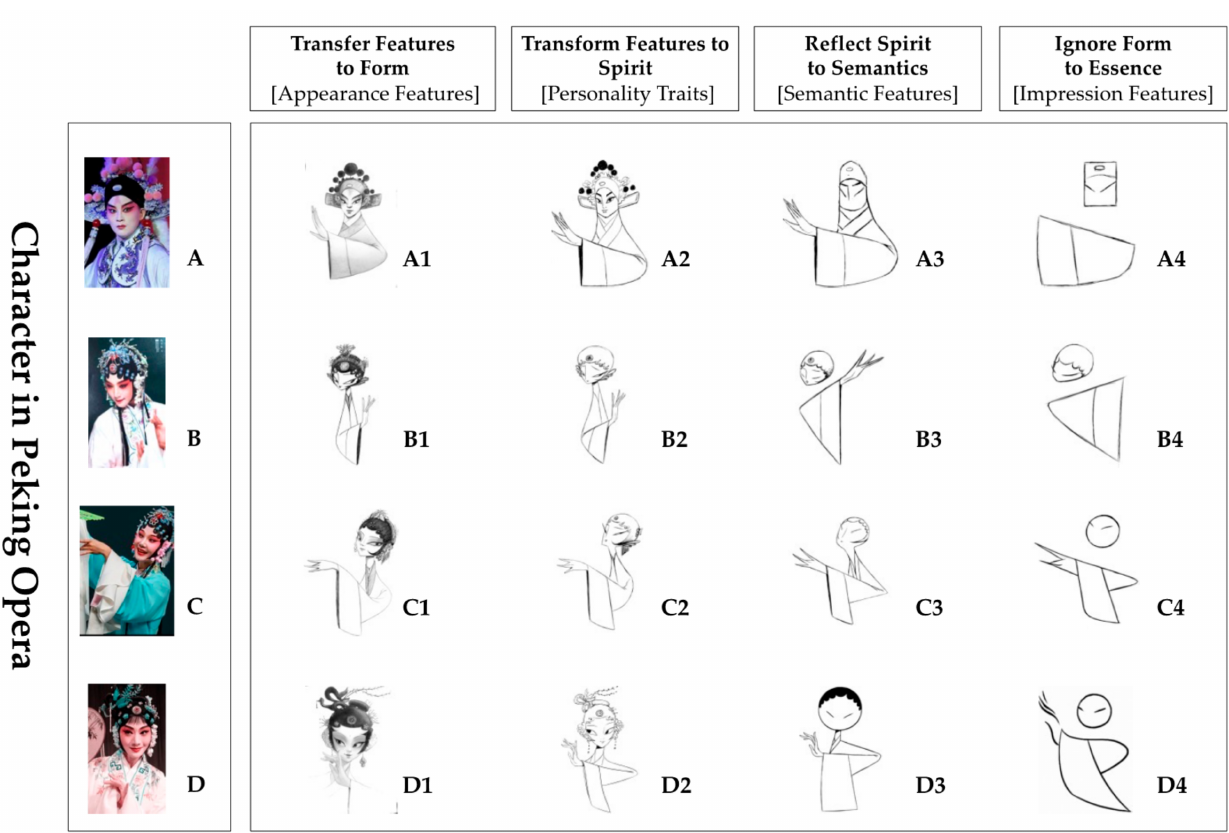
Figure 5. The samples and the four simplification steps (Source: this study).